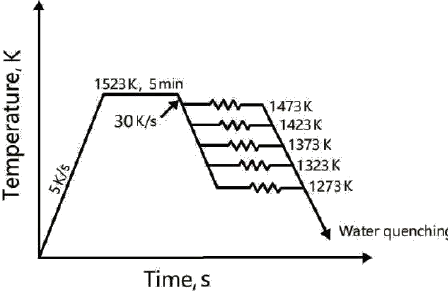
Figure 1. Schematic diagrams of the hot compression test.